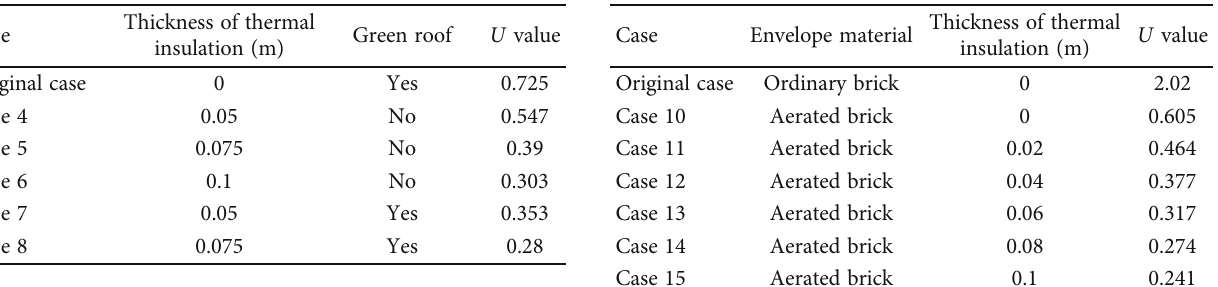
Figure 17: Space form of classroom A. Table 3: Roof construction of cases 4 to 14. Table 4: External wall construction of cases 15 to